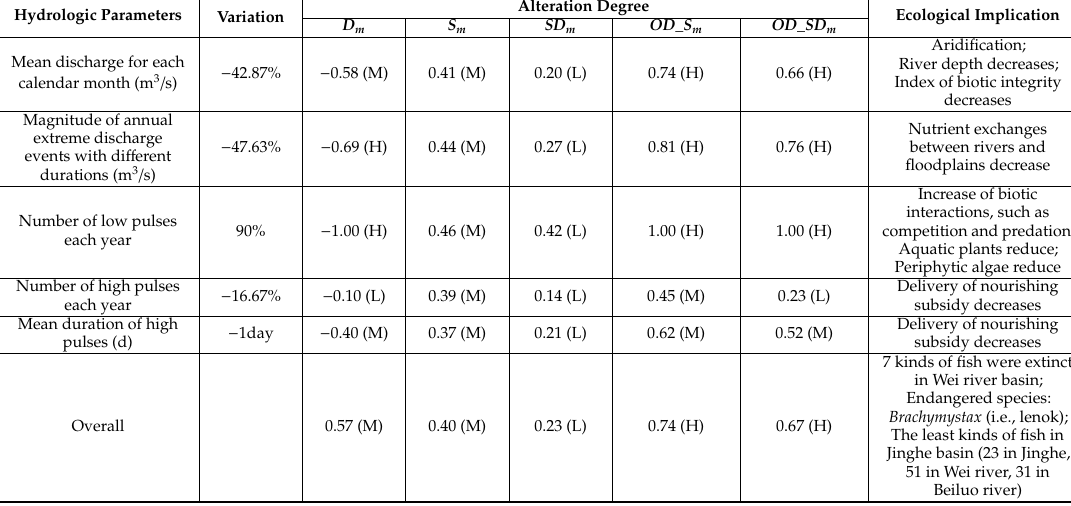
Table 4. The hydrologic parameters and corresponding changes related to fish